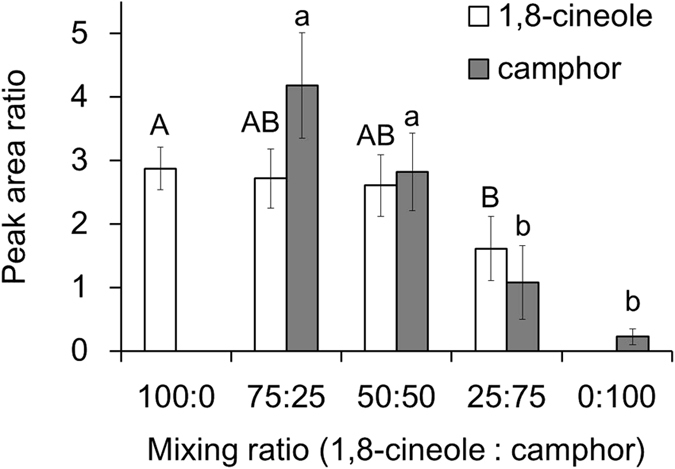
In vitro GC-MS analyses of the cuticular penetrations of 1,8-cineole and camphor in selected blending ratios.